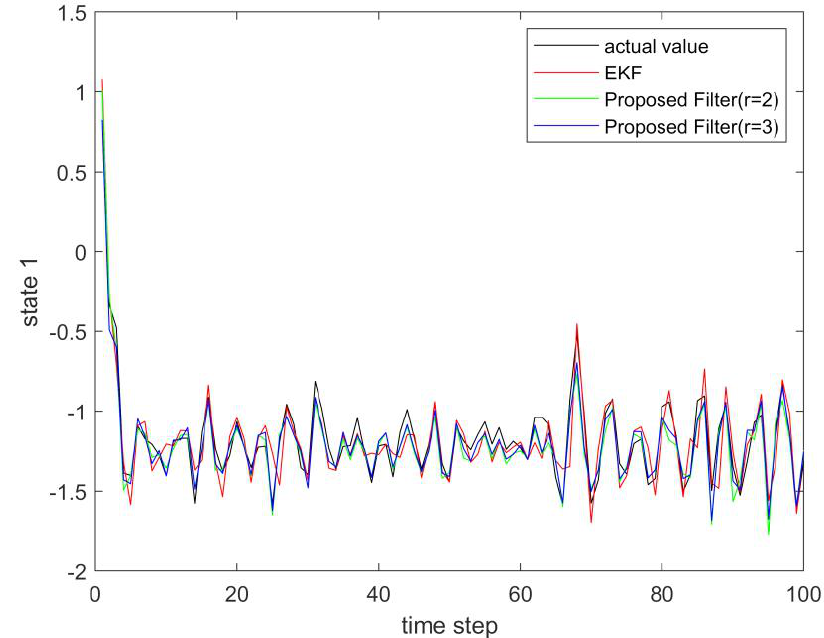
real value, the estimated value of EKF, the estimated value of the second-order extended dimension, and the estimated value of the third-order extended dimension for the state x 1 and state x 2 , respectively. Figures 11 and 12 show the estimated error of EKF, the estimated error of the second-order extended dimension, and the estimated error of the third-order extended dimension, respectively. Table 3 shows the error comparison between EKF and the dimension expansion methods.